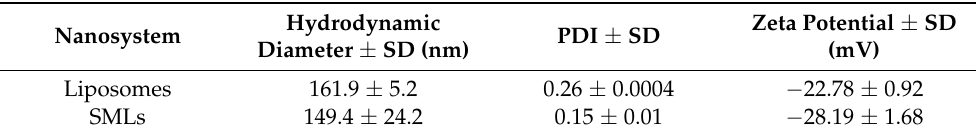
Table 5. Hydrodynamic diameter (nm), polydispersity index (PDI) and zeta potential (mV) and respective SD of liposomes of DOPE:Ch:CHEMS (45:45:10) and SMLs containing the same lipids